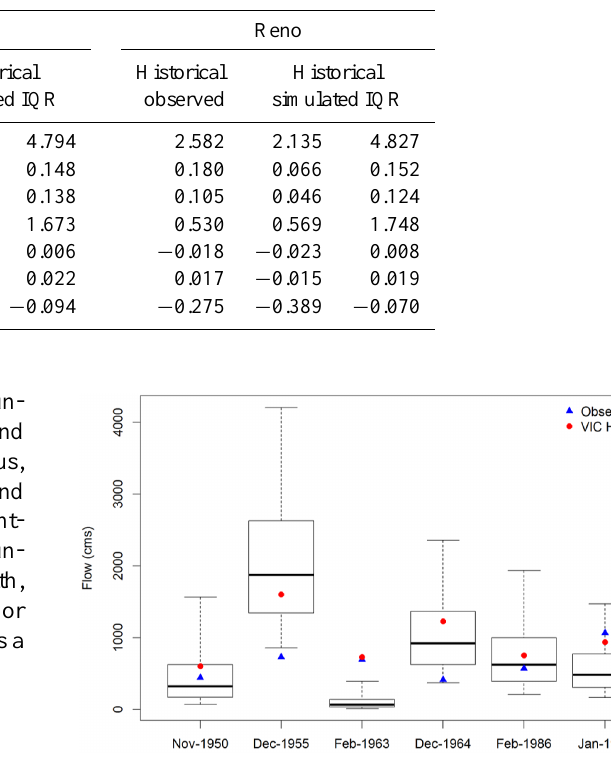
Figure 3. “Observed” unregulated flow estimated from gauge records (blue triangle) compared to VIC-simulated flow (red cir- cles) and the simulated GEV distribution. Boxes span the 25th to 75th percentile of the GEV distribution for a given month and the whiskers extend to the 5th and 95th